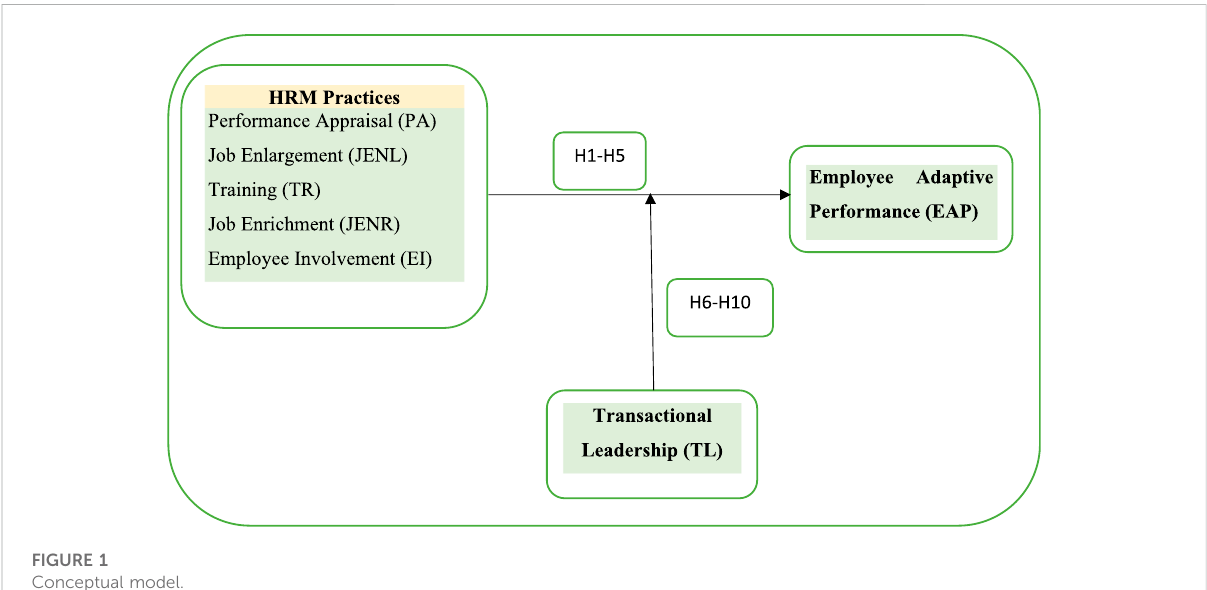
FIGURE 1 Conceptual